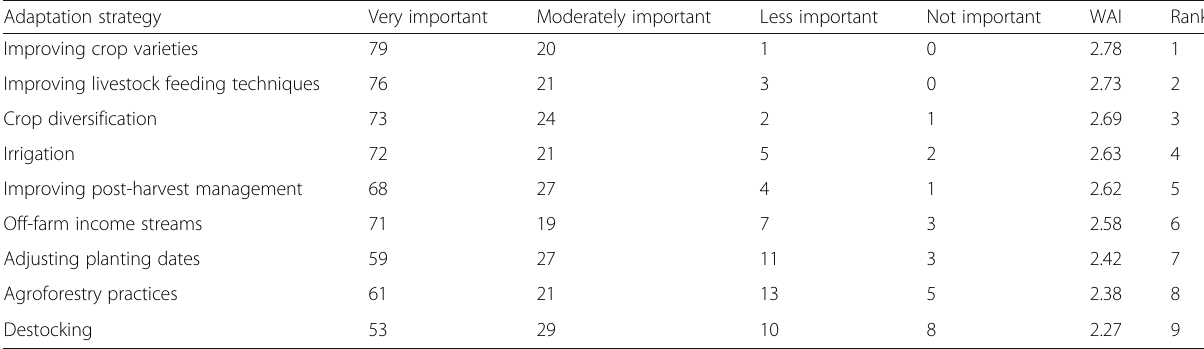
Table 3 Smallholder ’ s ranking of the adaptation strategies employed in Trans-Mara East sub-County, as per their perceived importance